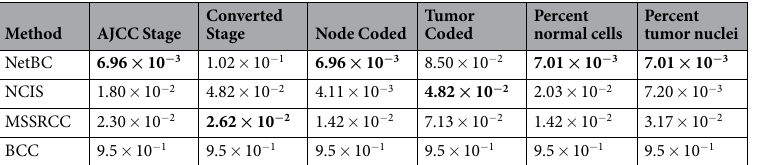
Table 2. p value of the dependence test between different clinical features and the discovered subtypes of Breast cancer. For all the clinical features, we use the Chi-squared test. The p value is adjusted by Benjamini & Hochberg method. The smaller the p value, the better the performance